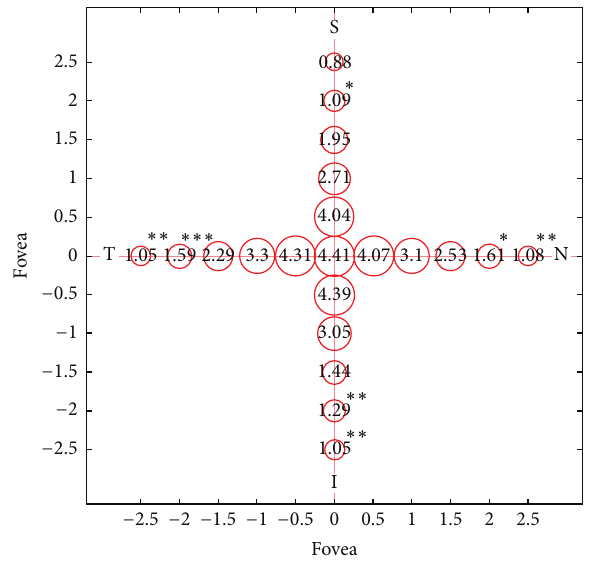
Figure 2: Correlation between the age of the patient and the choroidal thickness at different sites. Circle radii are proportional to the estimated correlation. Numbers represent the beta coefficients of the multivariate model for age at different sites (calculated from the interaction term in the model). Asterisks indicate in which sites the correlation between choroidal thickness and age is significantly different from the one found in the subfoveal region (chosen as the reference level in the